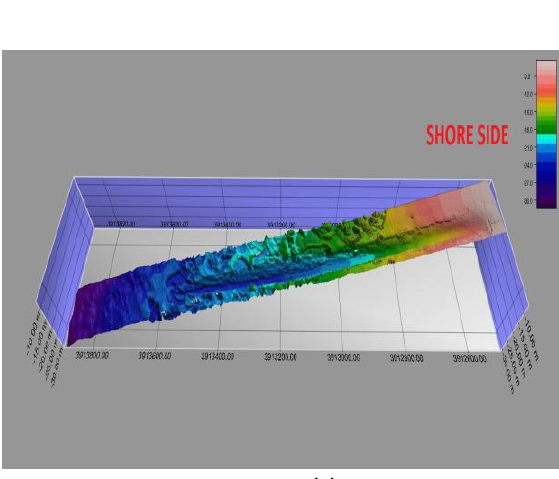
Figure 10: 3D seafloor models (a) Anamur_P2. (b) TRNC_P2.